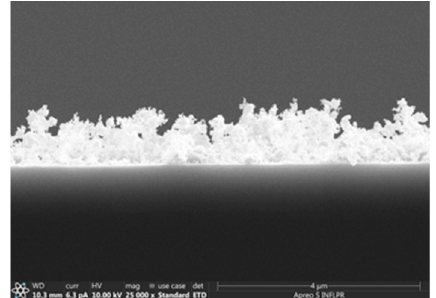
Figure 3. Cross-section SEM image of a ZnO film deposited in 2 h at a repetition rate of 10 kHz, a wavelength of 532 nm, using a laser power of 0.2 W, in 700 mTorr O 2